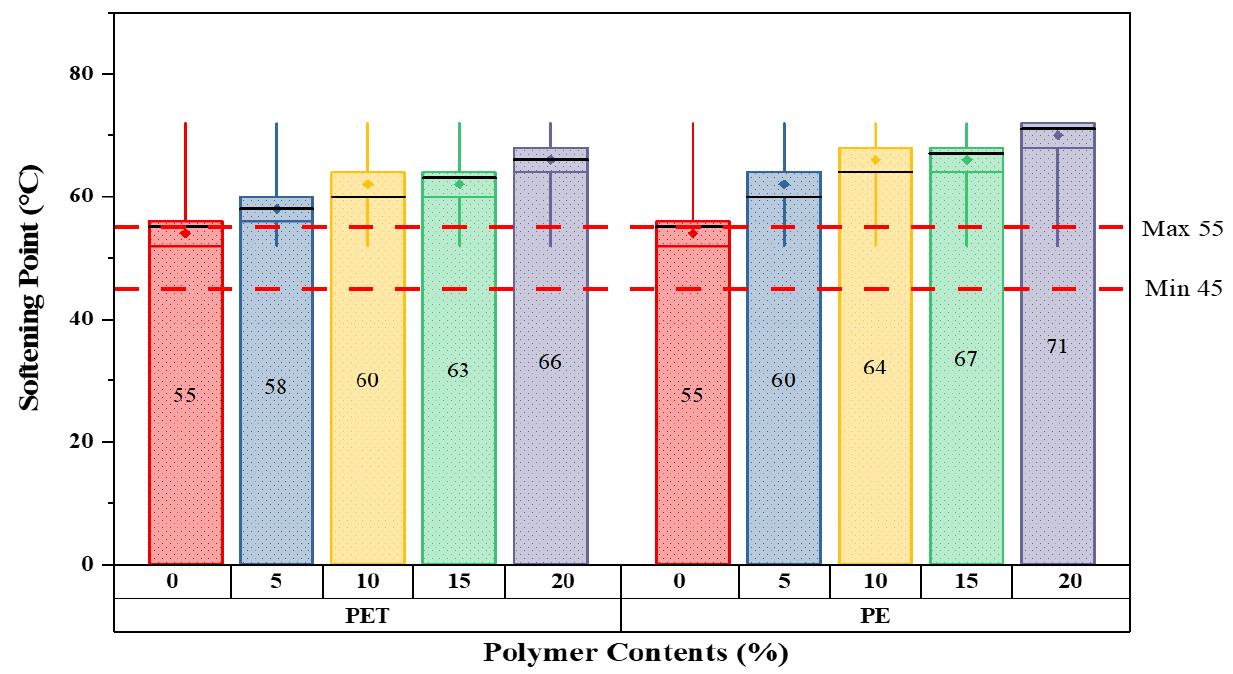
Figure 6. Softening point values with varying plastic content percentages.